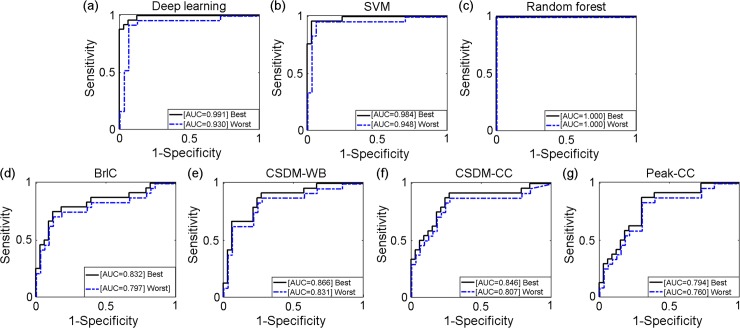
Comparisons of ROCs based on the training datasets.For the deep/machine learning techniques, only results from those with the RF-based feature selection are shown. The two ROCs correspond to the best and worst AUC, respectively.